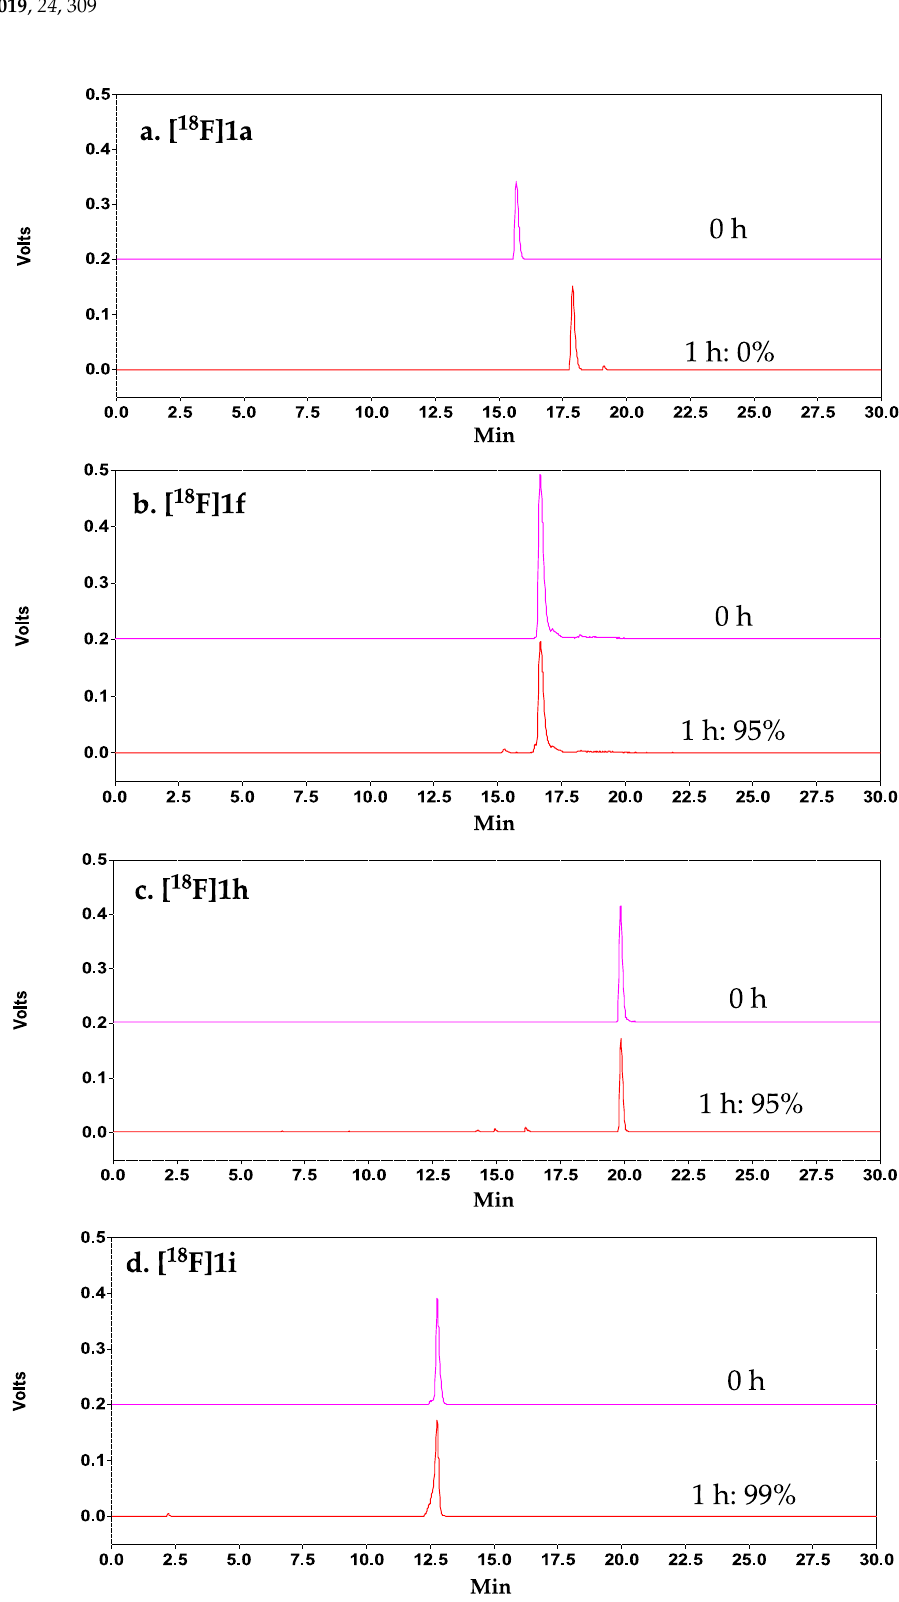
Figure 4. Radio ‐ RP ‐ HPLC chromatograms of the parent peptides ( a ) [ 18 F]1a , ( b ) [ 18 F]1f , ( c ) [ 18 F]1h , and ( d ) [ 18 F]1i (magenta) and their corresponding metabolites after 60 min incubating with mouse serum (red).